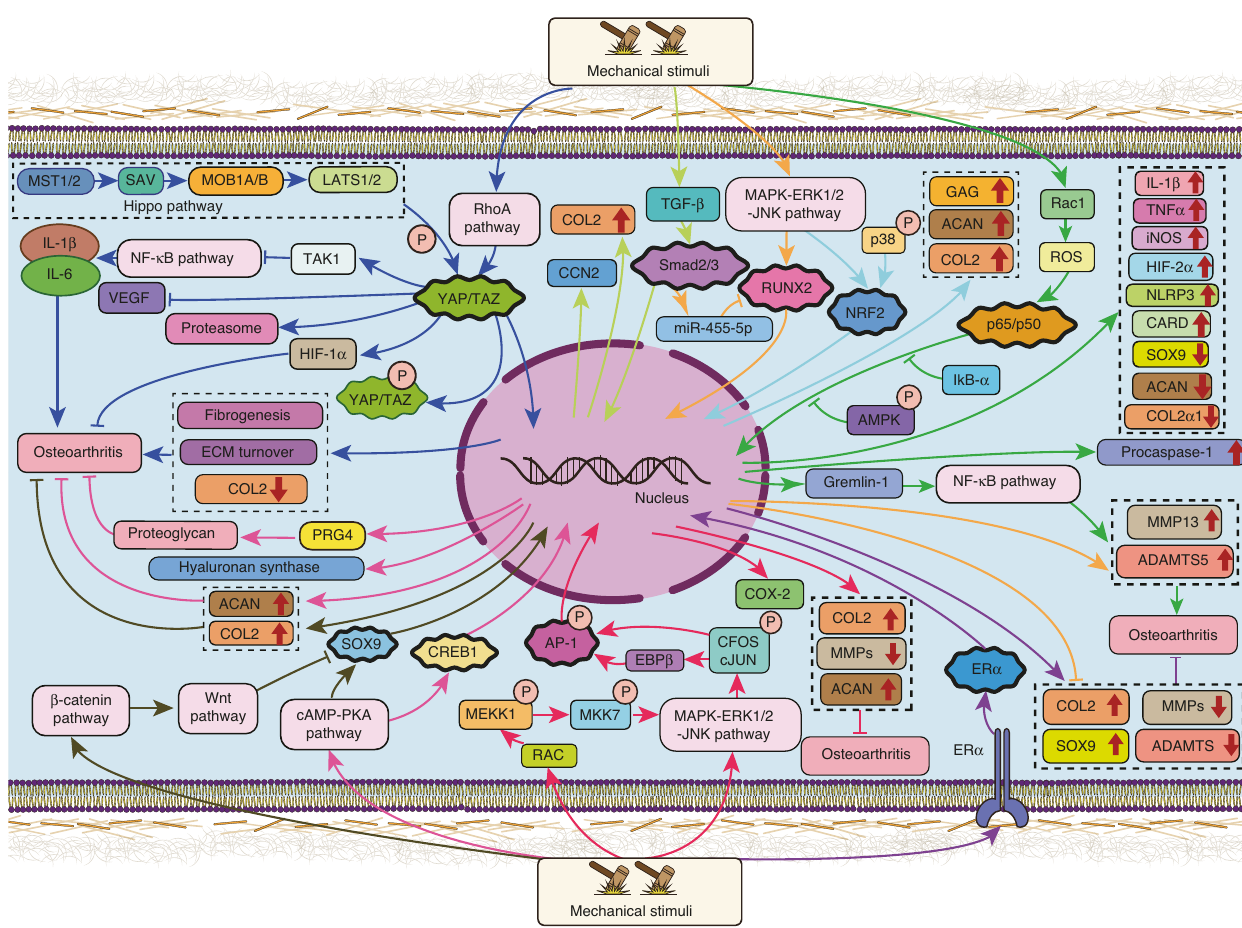
Fig. 3 Representative transcription factors that mediate chondrocyte responses to mechanical stimulation. Different colors indicate different pathways. Red indicates a supportive effect, pointed arrows indicate stimulatory effects, and blocked lines indicate inhibitory effects. YAP: Yes- Associated Protein, SAV: salvador, MST1/2: serine/threonine kinases STK4 (MST1) and STK3 (MST2), LATS1/2: large tumor suppressor 1 and 2, MOB1 A/B: MOB kinase activator 1, RhoA: Ras homolog gene family member A, TAZ: transcriptional coactivator with PDZ-binding motif, TAK1: Tgf- β -activated kinase1, IL1 β : interleukin-1 β , VEGF: vascular endothelial growth factor, HIF-1 α : hypoxia-inducible factor 1- α , COL2: collagen type II, PRG4: human proteoglycan 4, ACAN: aggrecan, SOX9: SRY-related high-mobility-group-box gene 9, CREB1: cAMP-response element- binding protein, CCN2: cellular communication network factor 2, TGF- β : transforming growth factor- β , Smad2/3: SMAD family member 2/3, RUNX2: Runt-related transcription factor 2, NRF2: nuclear factor erythroid2-related factor 2, AMPK: AMP-activated protein kinase, IkB- α : inhibitor of NF- κ B- α , ROS: reactive oxygen species, Rac-1: Ras-related C3 botulinum toxin substrate 1 (Rac1), GAG: glycosaminoglycan, TNF α : tumor necrosis factor α , iNOS: inducible nitric oxide synthase, HIF-2 α : hypoxia-inducible factor-2 α , NLRP3: nucleotide-binding oligomerization domain, leucine-rich repeat and pyrin domain-containing 3, CARD: caspase raise structural domain, MMP13: matrix metalloproteinase 13, ADAMT5: a disintegrin and metalloproteinase with thrombospondin motifs-5 (ADAMT-5), EBP β : CCATT enhancer-binding protein β (C/EBP β